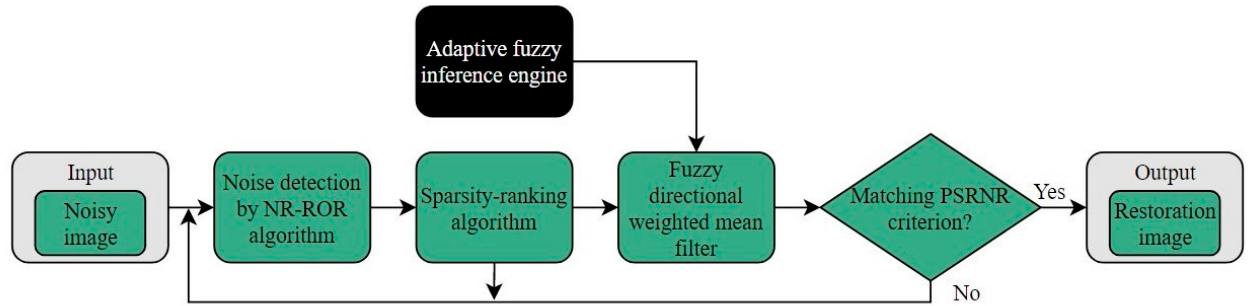
Figure 2. Structural flowchart of the proposed AFWMF model.